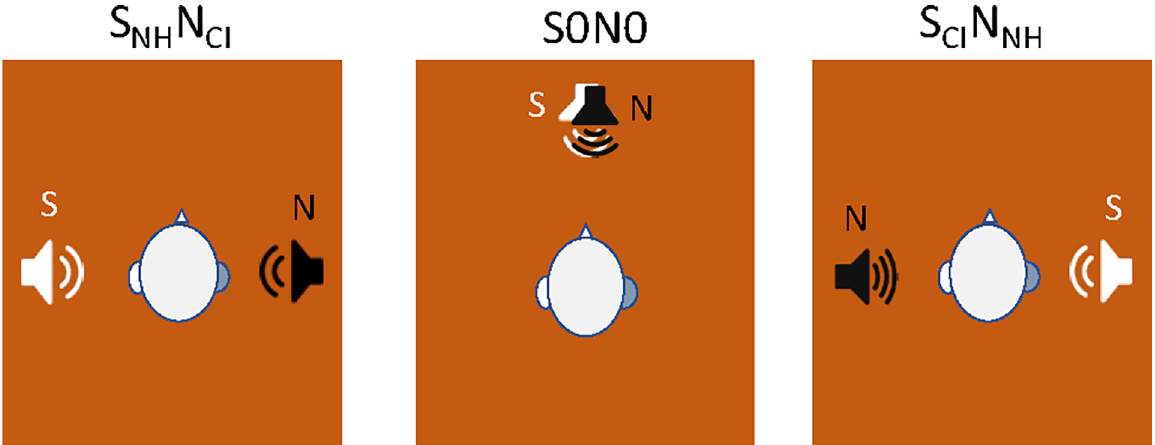
Fig 1. Spatial conditions for testing speech understanding in noise. Speech (S) was presented to the NH ear and noise (N) to the CI ear (S NH N CI ), or S and N were co-located directly in front of the subject (S0N0), or S was presented to the CI ear and N to the NH ear (S CI N NH ).